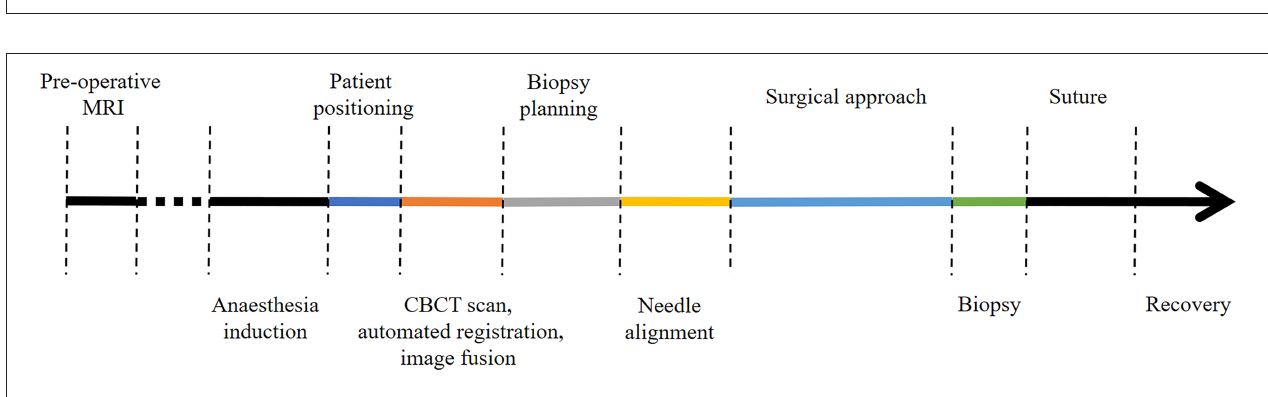
FIGURE 3 | Intraoperative workflow for navigated frameless stereotactic brain biopsy. (A) Finding the optimal skin incision site to match the entry point using the navigable pointer with real-time visual feedback on the system’s surgeon monitor. (B) After dura opening, the navigable biopsy needle has been advanced to the